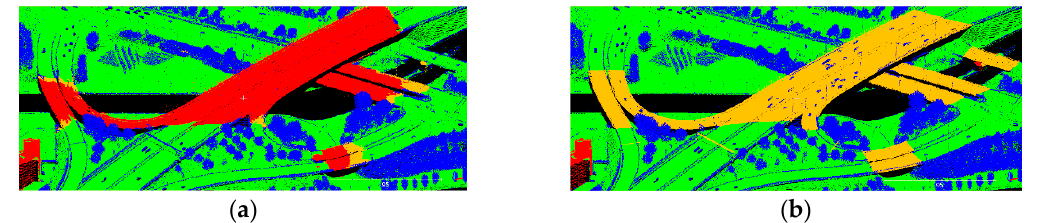
Figure 19. Elevated bridge: ( a ) FCN; ( b ) reference. Green: ground; blue: vegetation; red: building; yellow: bridge.